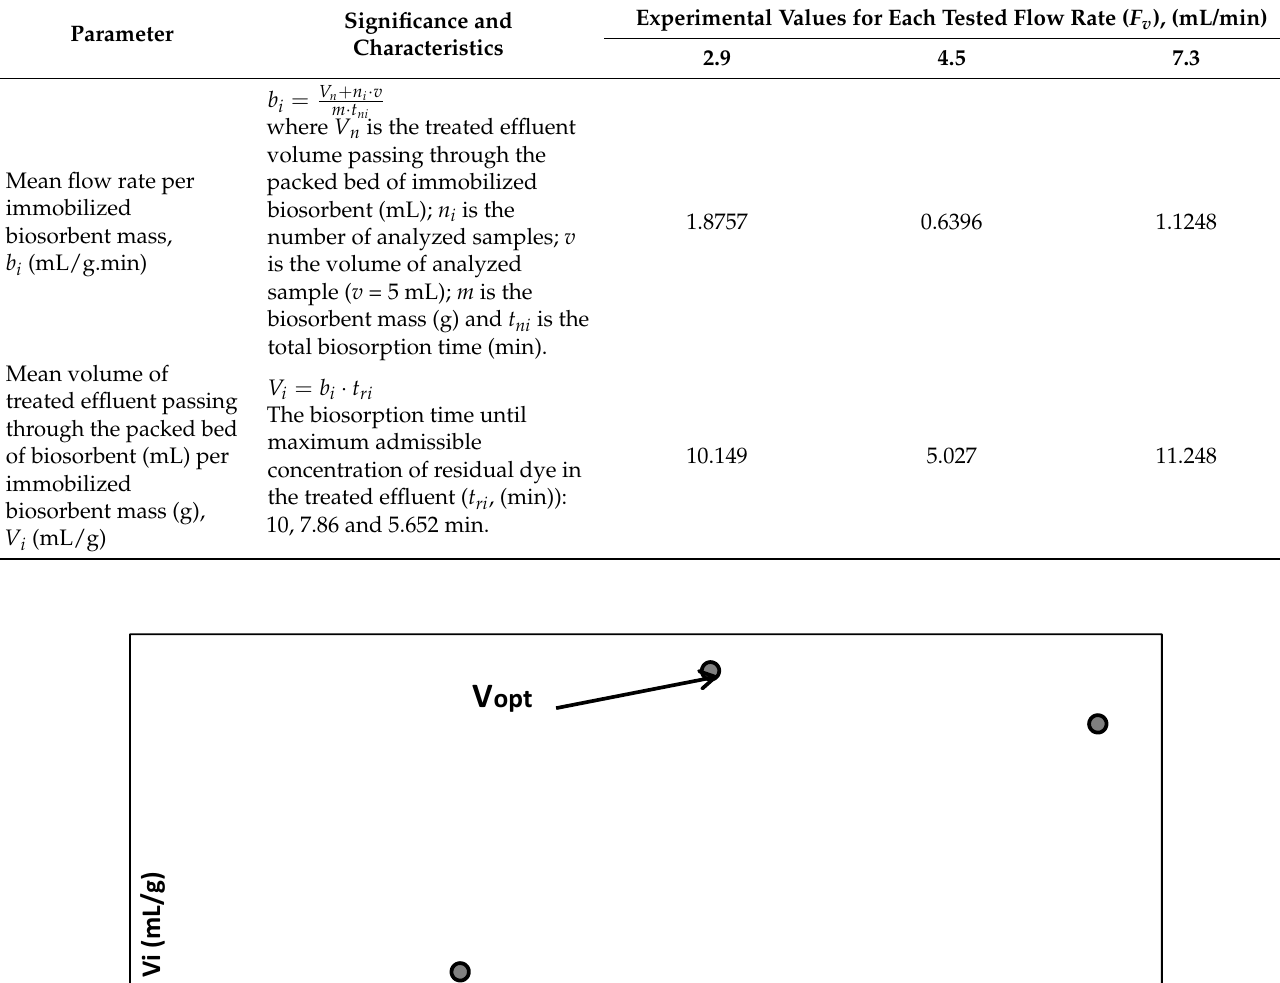
Table 4. V i vs. b i variation and optimal volume ( V opt ) determination.